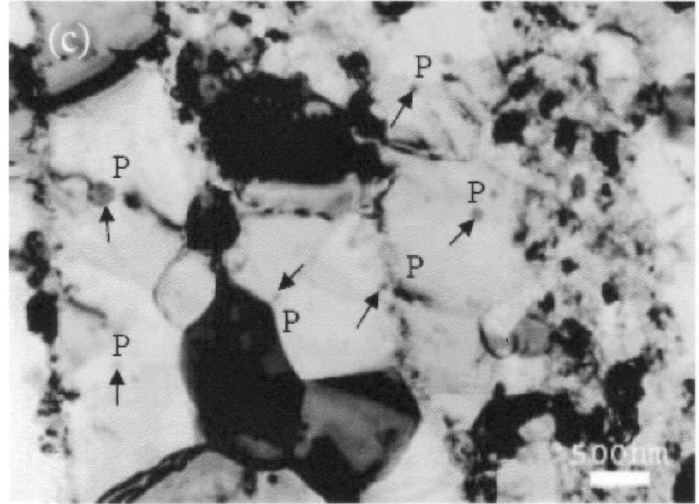
Figure 16. High magnification TEM micrograph of an annealed sample at 573 K for 50 h showing the presence of nanoscale dispersion particles (marked ―P‖) in and along the grain